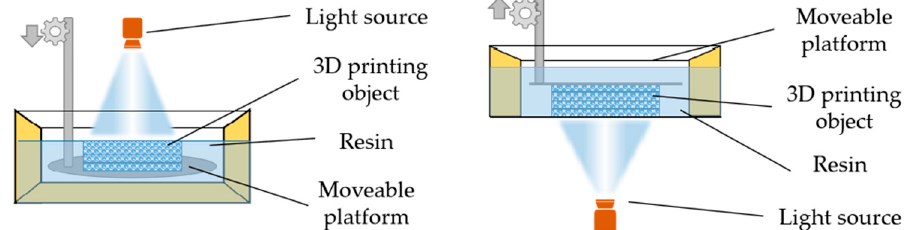
Figure 2. The schematics of mask-projection stereolithography for bottom-up system ( left ) and top-down system ( right ). The light source is scanning laser or digital light projection.